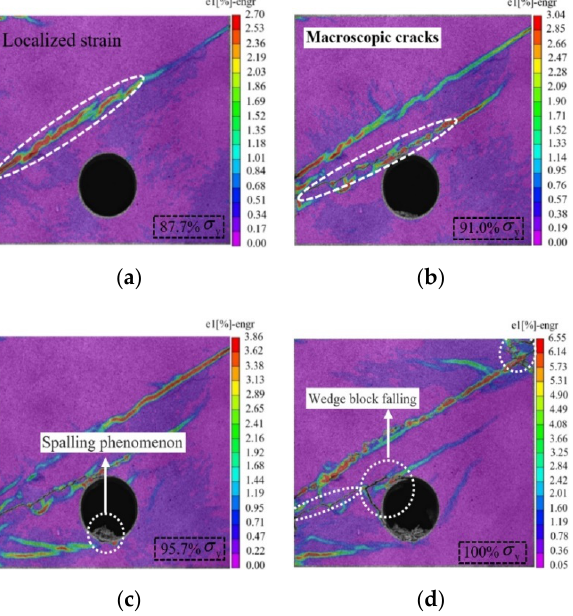
Figure 21. Evolution process of the major principal strain field of sample L ‐ 3. ( a ) 87.7% σ y ; ( b ) 91.0% σ y ; ( c ) 95.7% σ y ; ( d ) 100% σ y .